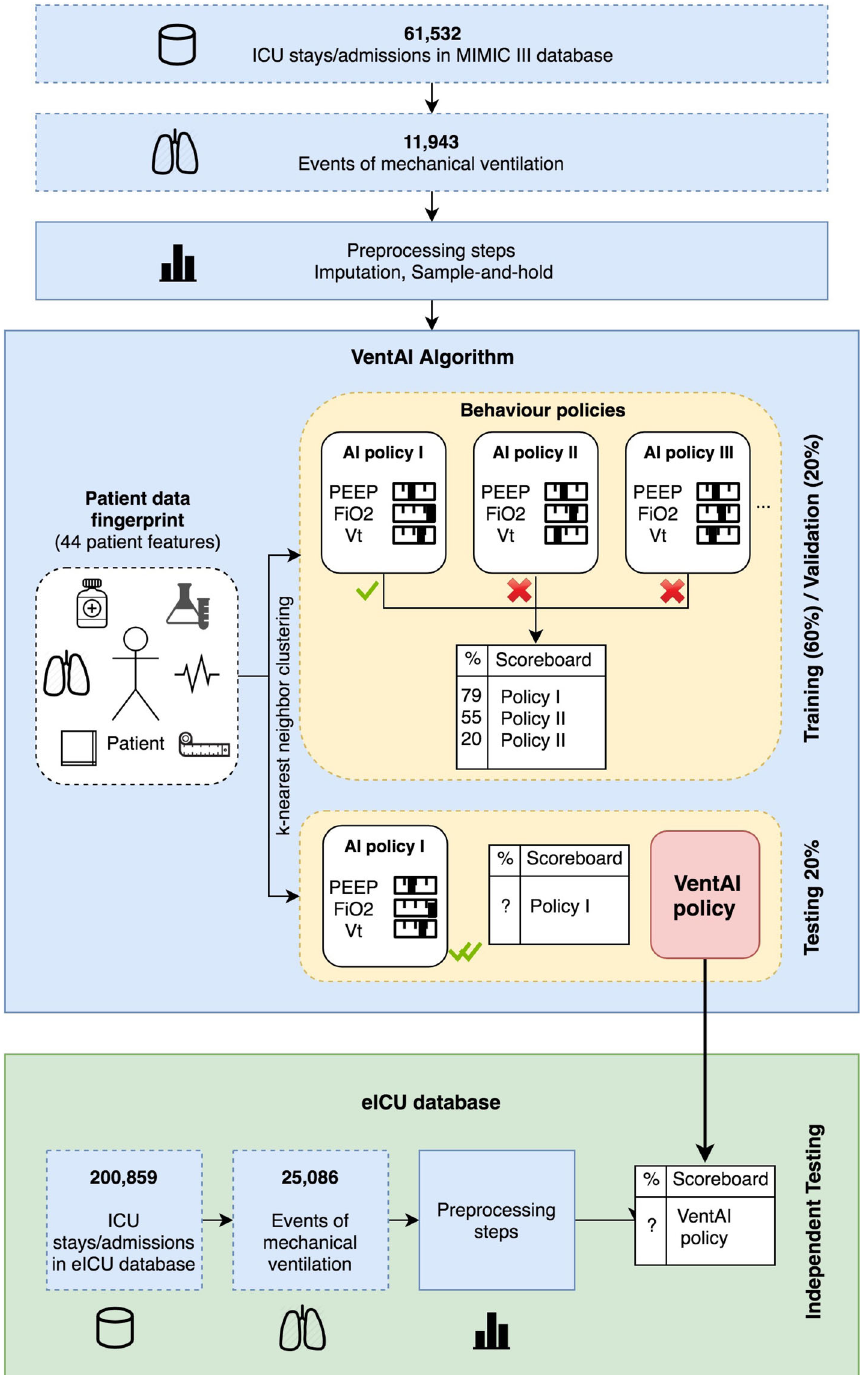
Fig. 1 VentAI Data Routine. Flow diagram of the overall cohort, architectural overview of the VentAI algorithm and independent testing on eICU